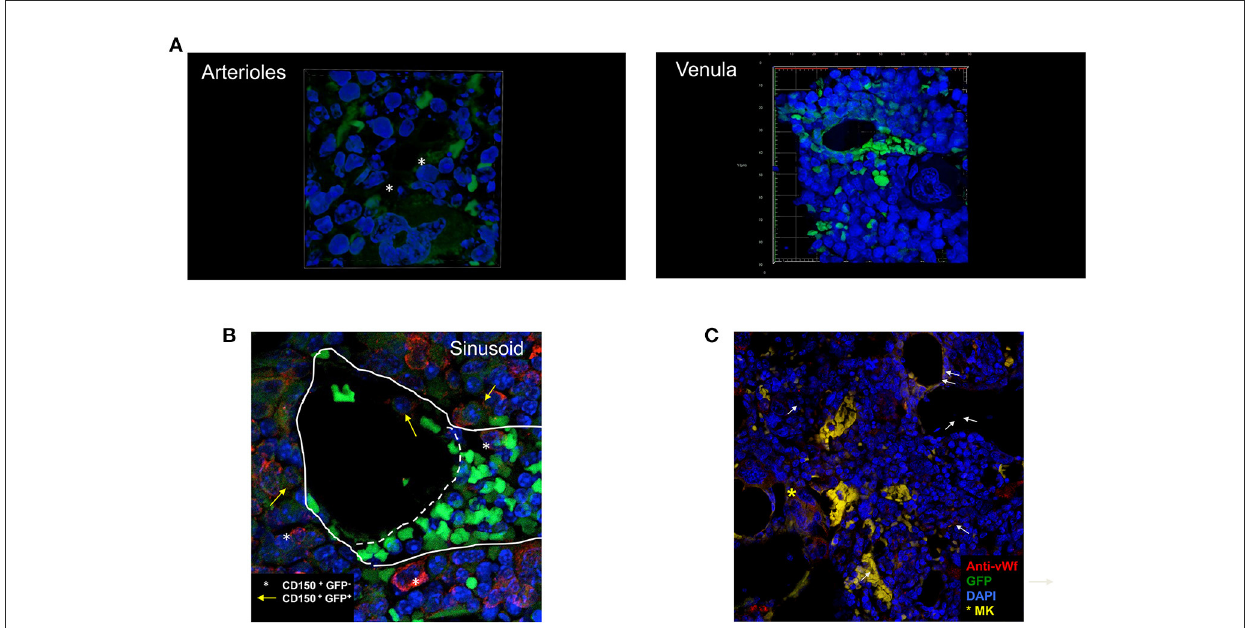
FIGURE5 Cells expressing high levels of GFP are often found located around vessels. (A) 3D reconstruction of an arteriole (top panel) and of a venula (bottom panel) surrounded by small GFP positive cells. (B) Confocal microscopy observation of a representative BM section stained with the von Willebrand (vWF) antibody. The arrows indicate representative GFP pos cells localized around the vessels which are lined by vWF positive cells. To be noted the presence of a vessel surrounded by vWF positive endothelial cells which does not contain GFP-positive cells (symbol) but associated with a megakaryocyte in the process to release platelets (the large cells with multi-lobated nucleus positive for vWF indicated by the asterisk). (C) Confocal microscopy observation of a representative BM section stained with the CD150 antibody showing that all the GFPpos cells around the vessel are also CD150pos (yellow arrows) while there are same CD150pos which are not labeled by GFP (asterisks). The image shows the anastomosis between two venules, one cut transversally and another one cut longitudinally. This anastomosis identifies the two vessels as sinusoids. The straight line indicates the localization of the basal lamina while the dotted line indicates the junction between the two vessels. The small green cells in the vessel cut longitudinally are red blood cells. To be noted the GFPposCD150 + cells located in the lumen of the vessel cut transversally and the GFPnegCD150pos cells located near the transversal vessel that appears in cytodieresis. Original magnification x600 (arterioles and venula) and x200 in all the other